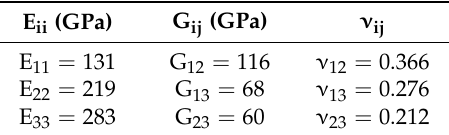
Table 3. Direction-dependent values of Young Modulus (E ii ), Shear Modulus (G ij ), and Poisson coefficient ( ν ij